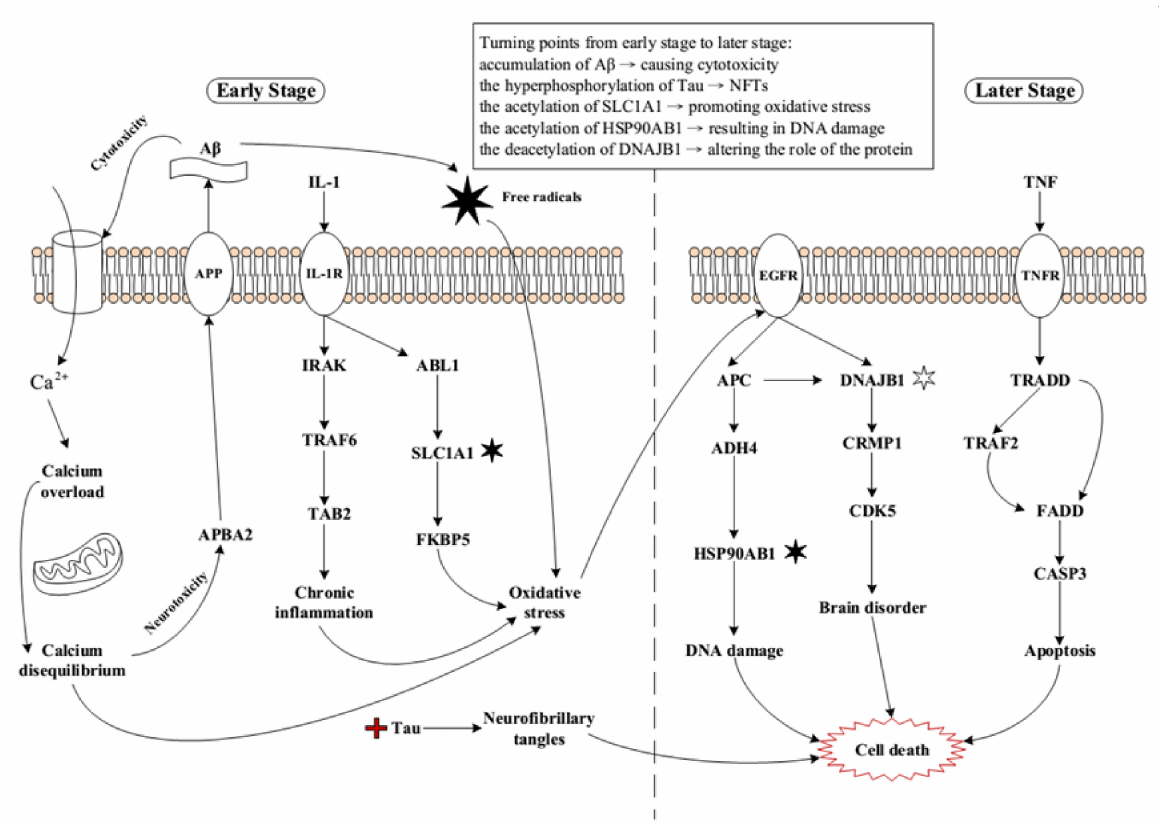
Figure 5. The overview of pathogenic mechanism of AD from early stage to later stage. The left part represents the pathogenic mechanism in early-stage AD, and right part indicates the pathogenic mechanism in later stage AD. The arrow lines denote the protein-protein interactions or regulations from the upstream to downstream. Notations of genetic and epigenetic regulations are the same as Figures 3 and